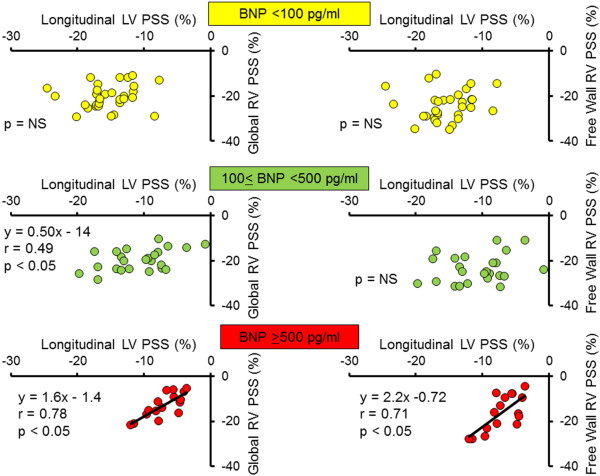
Scatter plots depicting the correlation between global RV PSS and global LV PSS in the apical 4-chamber view (left) and between free wall RV PSS and global LV PSS in the apical 4-chamber view (right) in patient with BNP <100 pg/ml (top, n = 31), 100 ≤BNP <500 pg/ml (middle, n = 24), and BNP ≥500 pg/ml (bottom, n = 16).